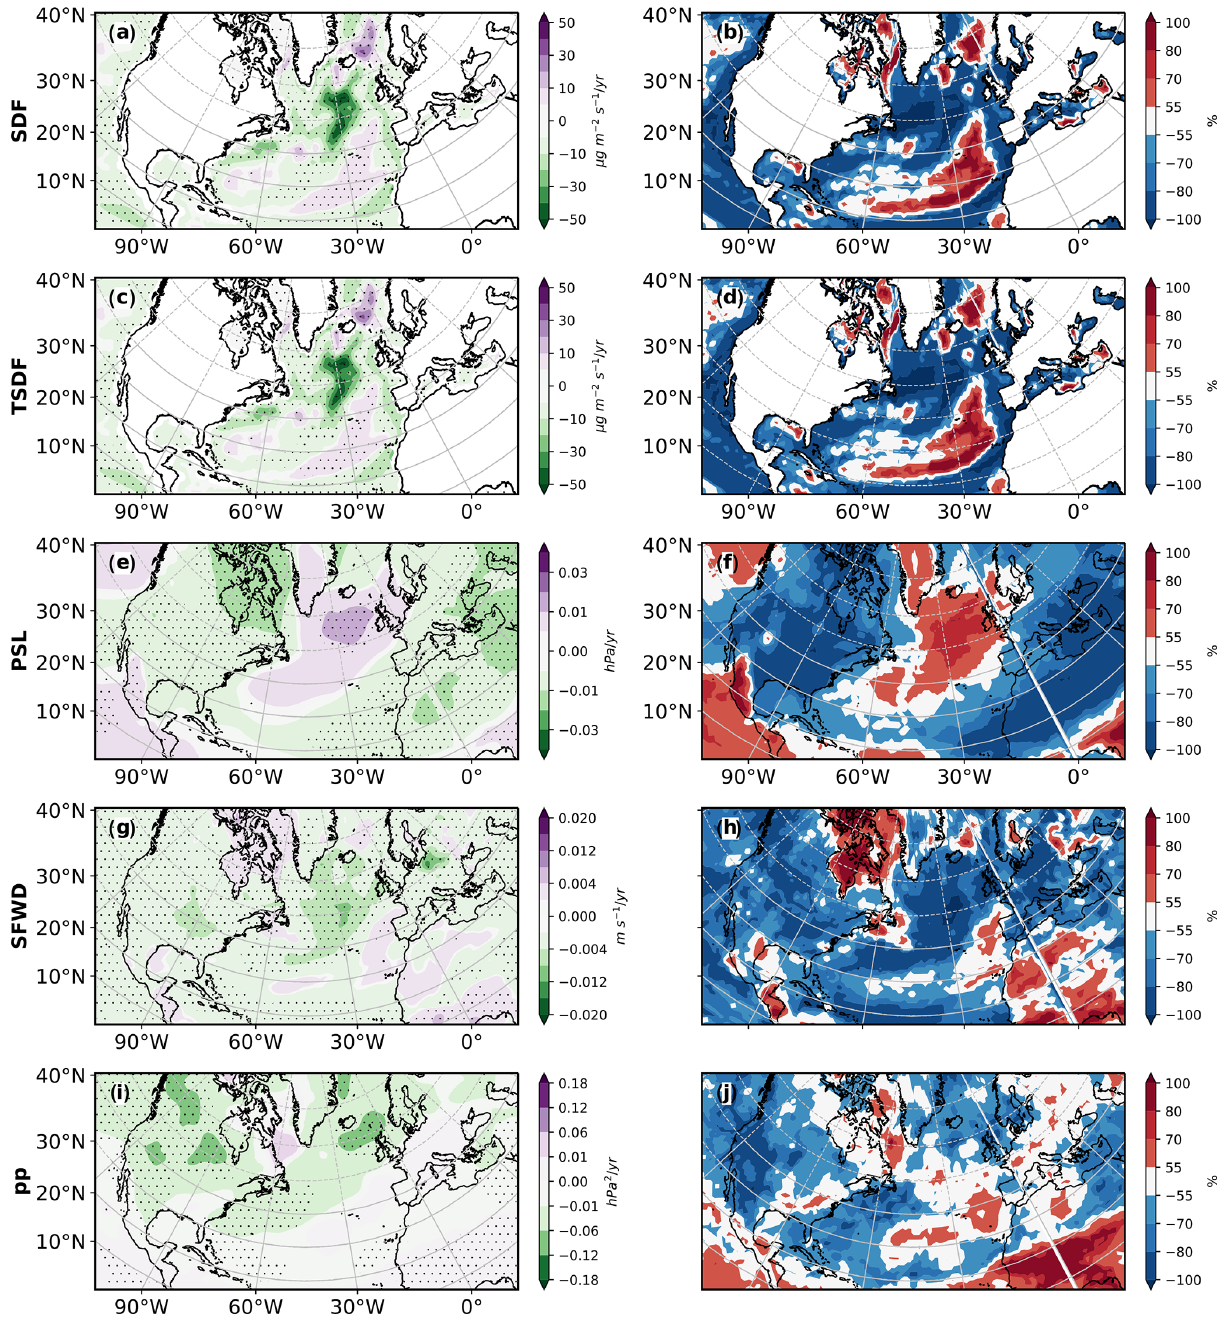
Figure 8. 1990–2020 annual mean all forcing Coupled Model Intercomparison Project phase 6 ensemble mean trends and model agreement on the sign of the trend: (a, b) surface density flux (SDF); (c, d) thermal SDF (TSDF); (e, f) sea level pressure (PSL); (g, h) surface winds (SFWD); and (i, j) storm track activity (pp). Panels (a, c, e, g, i) show the ensemble mean trend; panels (b, d, f, h, j) show model agreement on the sign of the trend for each model’s ensemble mean. Symbols in (a, c, e, g, i) designate trend significance at the 95% confidence level based on a t test. SDF and TSDF trend units are µgm − 2 s − 1 yr − 1 . PSL, pp, and SFWD trend units are hPayr − 1 , hPa 2 yr − 1 , and ms − 1 yr − 1 , respectively. Trend realization agreement units are %. Red (blue) colors indicate model agreement on a positive (negative) trend.